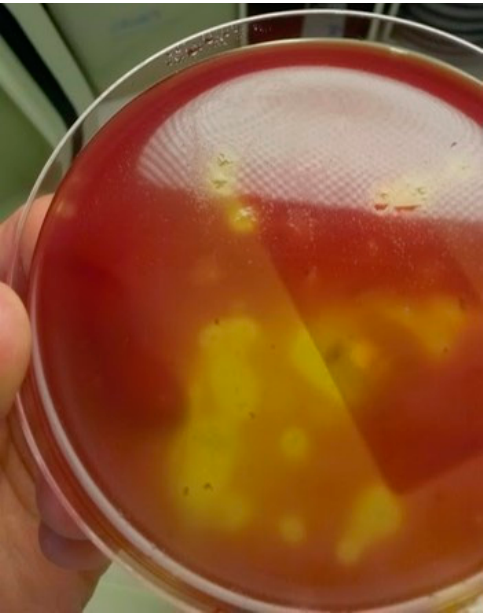
Figure 2. Colonies of Clostridium haemolyticum on fastidious anaerobe agar. Identification of the isolate (strain LBN 1021) from plates was performed using the Vitek MS and the Maldi Biotyper systems as previously described [24]. With the Vitek MS system (database version 2.0), the isolate remained unidentified either at the species or the genus level after direct deposit, on-plate formic acid treatment and ethanol–formic acid extraction. With the Biotyper system (IVD version, with 5627 entries), the isolate could not be identified after direct deposit, whereas a correct identification was achieved after ethanol–formic acid extraction. This identification was also confirmed by using a